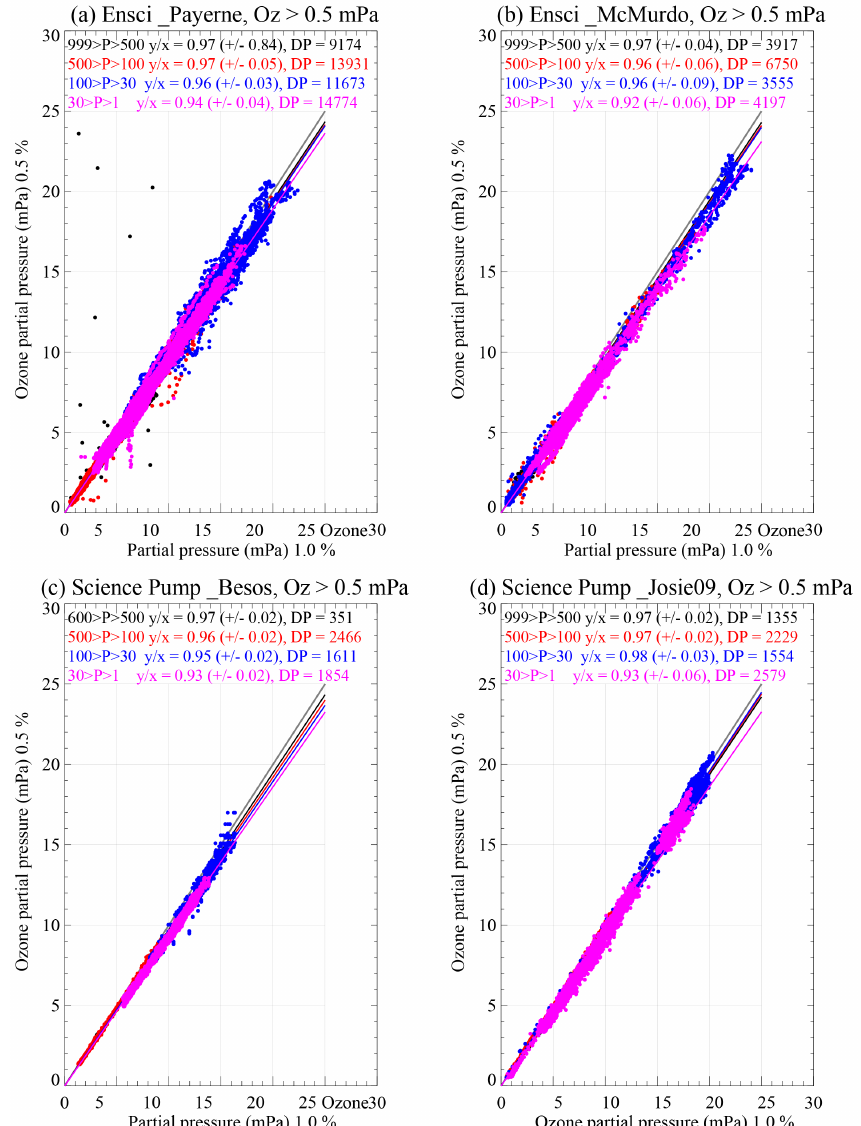
Figure 5. Scatterplots of ozone partial pressures measured with KI concentrations of 1.0% ( x axis) and 0.5% ( y axis) using EN ozonesondes flown from (a) Payerne and (b) McMurdo Station, and with SP ozonesondes from (c) BESOS and (d) JOSIE09. The data are subdivided into four pressure intervals, and averages and standard deviations of the ratios of y : x are listed on the panels along with the number of measurements (noted as DP for data points). Only ozone measurements above 0.5mPa are included. At p ≥ 30hPa there is little variation in the ratios by pressure interval, location, or ozonesonde type. At p <30hPa ratios are decreasing. The 1 : 1 line is shown in